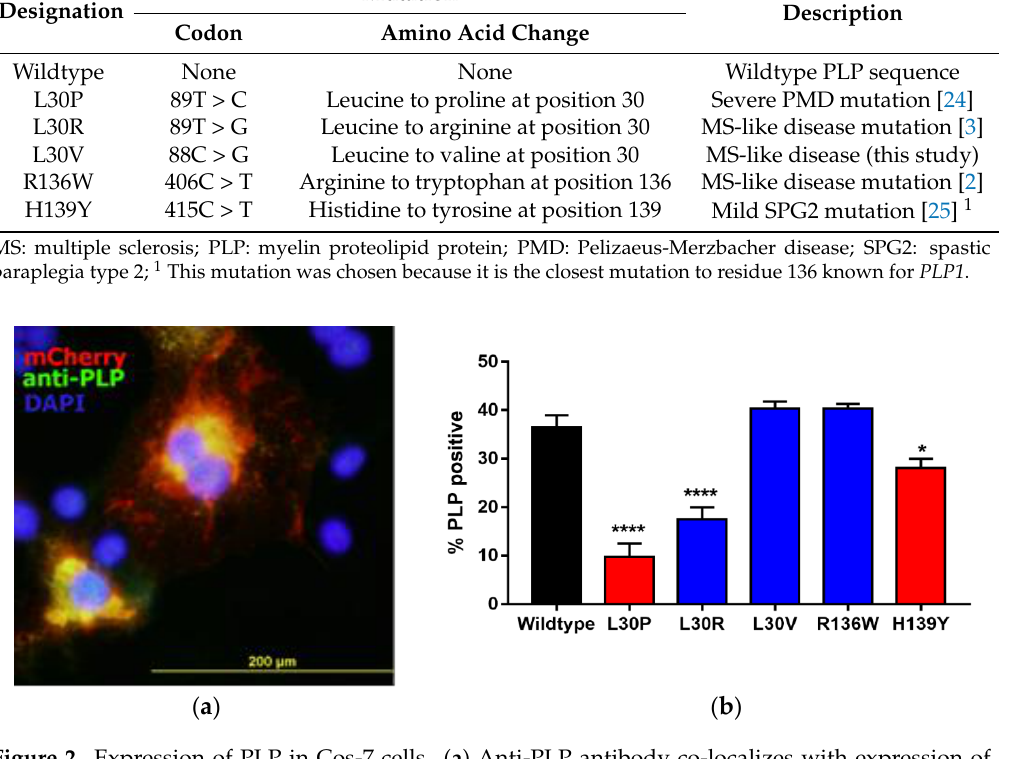
Figure 2. Expression of PLP in Cos-7 cells. ( a ) Anti-PLP antibody co-localizes with expression of mCherry in transfected Cos-7 cells after 24 h in culture. ( b ) Percentages of cells transfected with the different PLP1 constructs that expressed PLP after 48 h in culture. Bars show mean ± SE of four experiments. The black bar shows cells transfected with the wildtype construct, the red bars are those transfected with constructs based on known Pelizaeus-Merzbacher disease/spastic paraplegia type 2 (PMD/SPG2) mutations, and the blue bars are cells transfected with constructs containing the MS-related mutations. * p < 0.05, **** p < 0.0001.